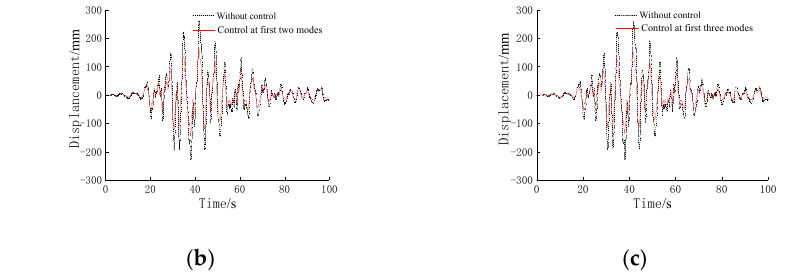
Figure 19. Time history of displacement by optimized control at different modes under the Jiangyou seismic record. ( a ) First mode. ( b ) First two modes. ( c ) First three modes.